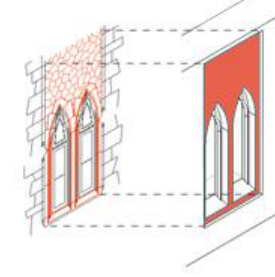
Figure 10. The traced 2D photogrammetric survey data assists further in locating and modeling material masses, creating a LoD 2 model.